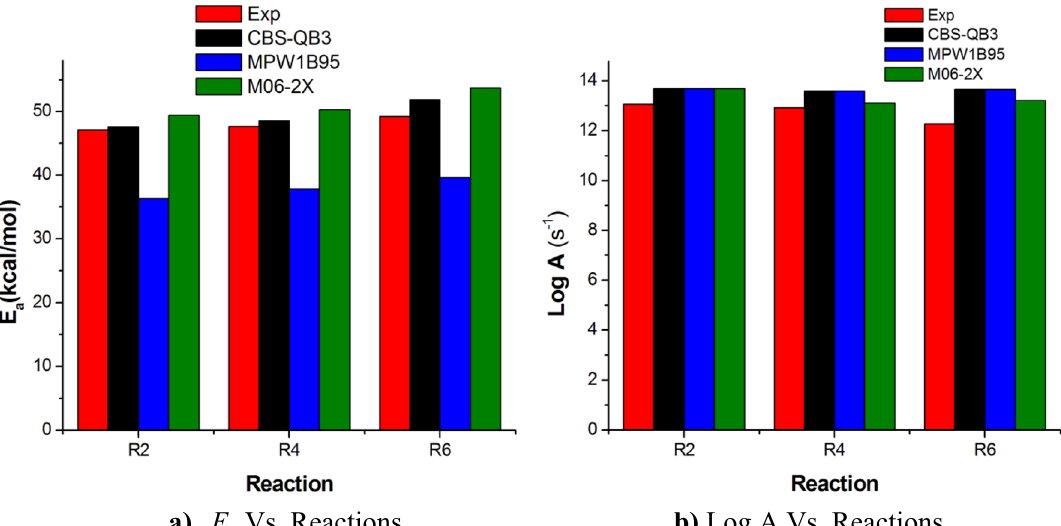
Figure 10. Comparison of the experimental 14,16 and computational results of activation energies ( E a , kcal/mol) and Pre-exponential factors (Log A) of the main dominant reactions R2, R4, and R6 under T = 650 K at different energies